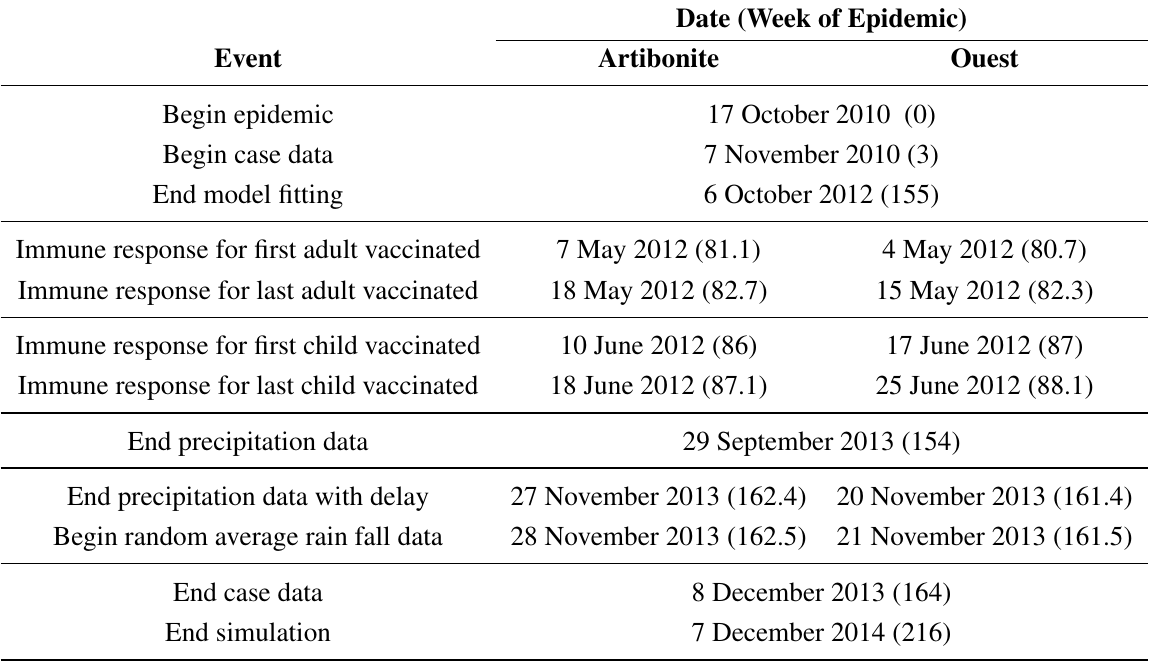
Table 6. Time line for modeling